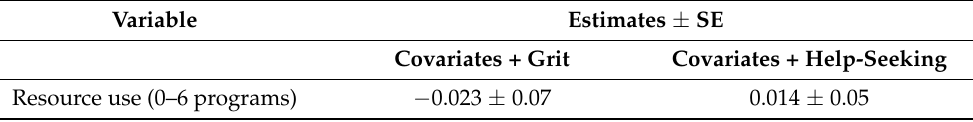
Table 4. Grit and help-seeking were not associated with resource use among rural Illinois veterans ≥ 18 years recruited from five food pantries from March 2021 to November 2021 1 .